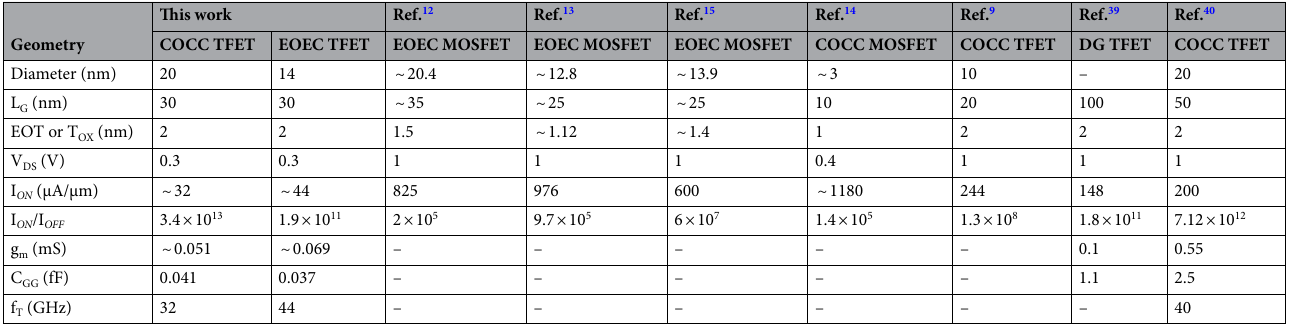
Table 2. Details of proposed EOEC and COCC structures against several GAA MOSFETs and